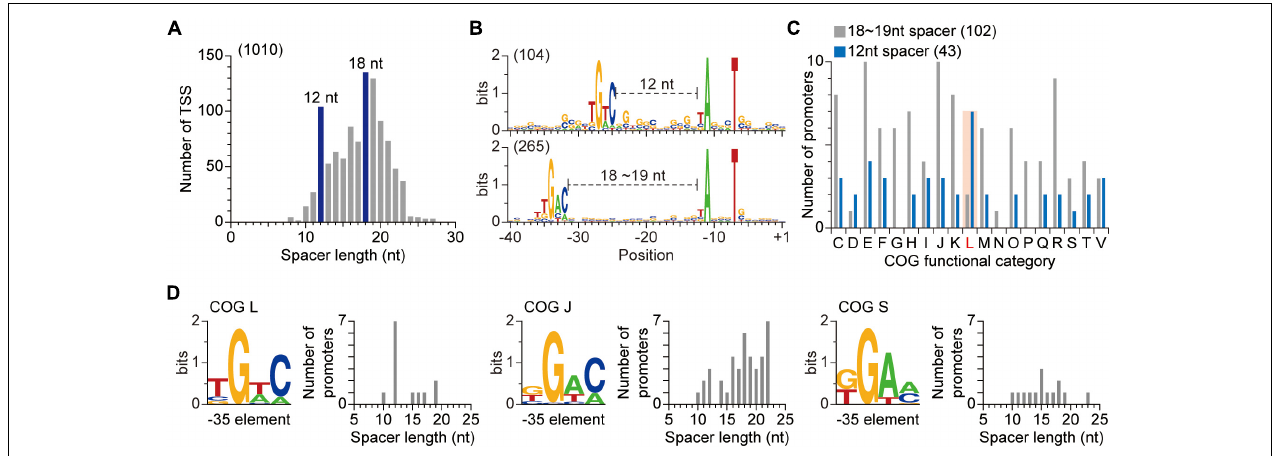
FIGURE 2 | Relationship between promoter sequences and the function of the corresponding gene. (A) The spacer lengths of S. lividans TK24. The spacer length was calculated for transcription start sites whose − 10 and − 35 elements were simultaneously discovered. (B) Differences in promoter sequences with different spacer length. (C) Functional analysis of genes exploiting two different types of promoter. Genes with 12 nt spacer are functionally enriched in COG category L, which represents DNA replication, recombination and repair. (D) Variation of − 35 element sequence and spacer length dependent on the function of